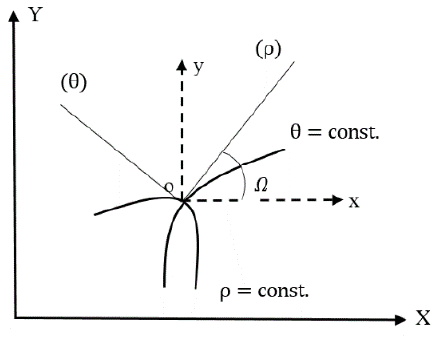
Figure 2. Convert Cartesian coordinate ( x , y ) to curvilinear coordinate ( ρ , θ ).